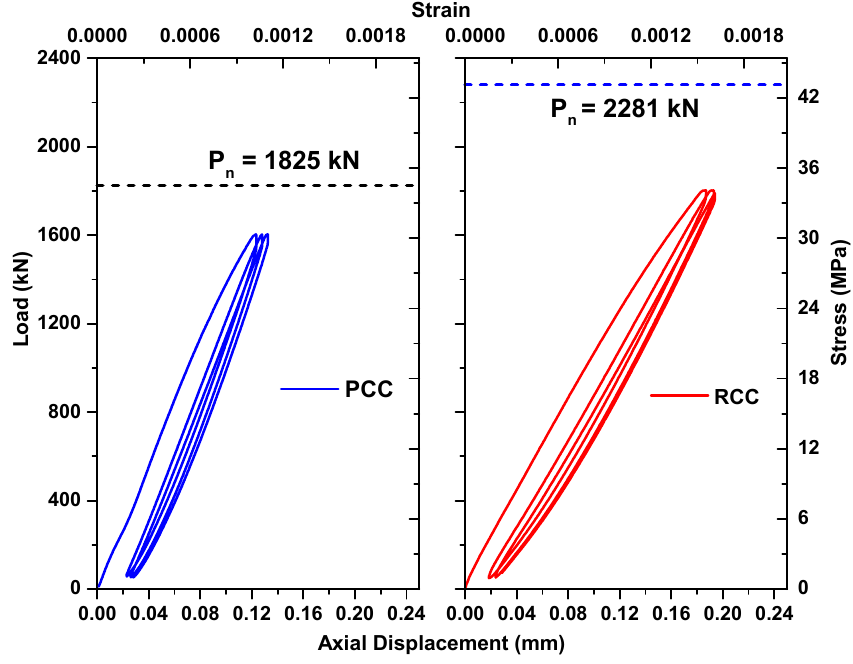
Figure 3. Cyclic pre-damage of plain concrete and reinforced concrete columns.